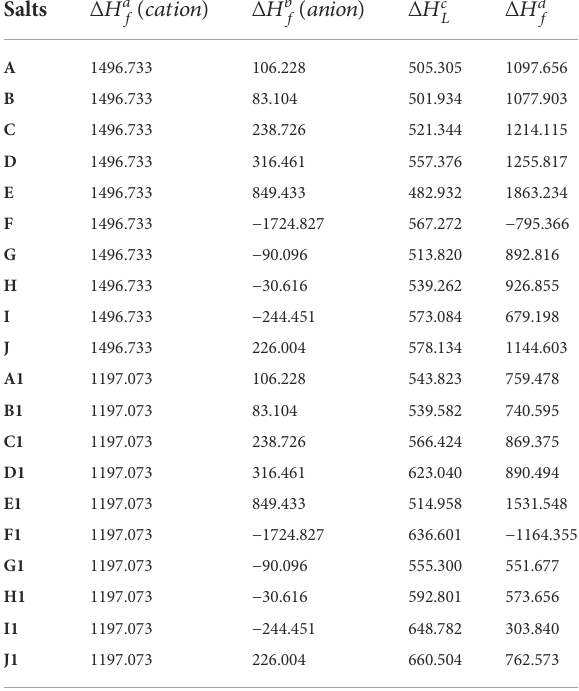
TABLE 2 The enthalpy of formation of O 2 + and N 5 + , various anions and their corresponding salts ( Δ H f ) (A to J for N 5 + salts and A1 to J1 for